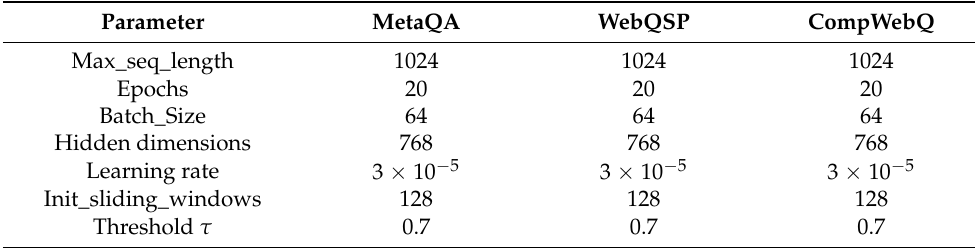
Table 3. Hyperparameter